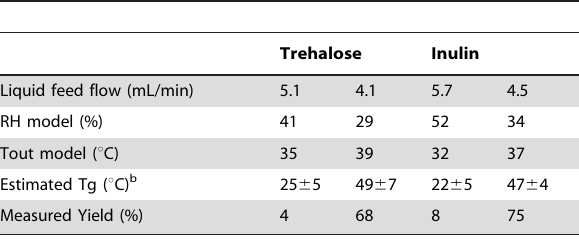
Table 3. Trehalose and inulin yield depending on spray drying conditions.